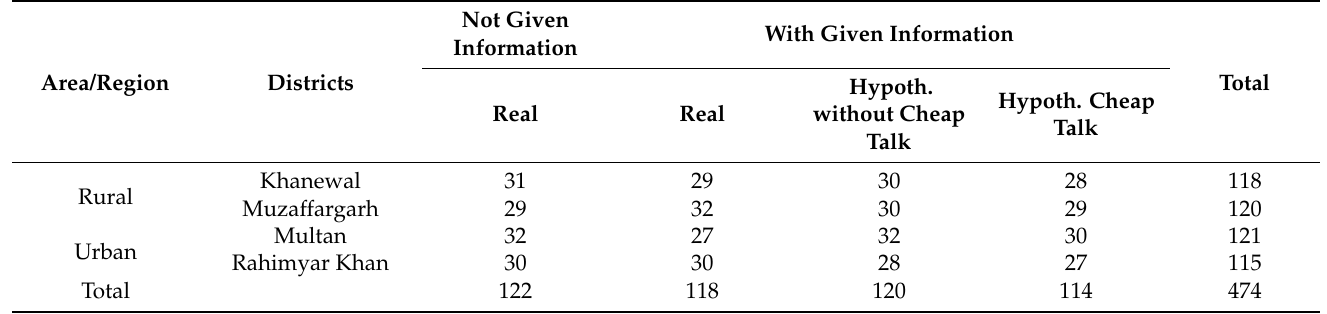
Table 2. Distribution of respondents with respect to approaches and